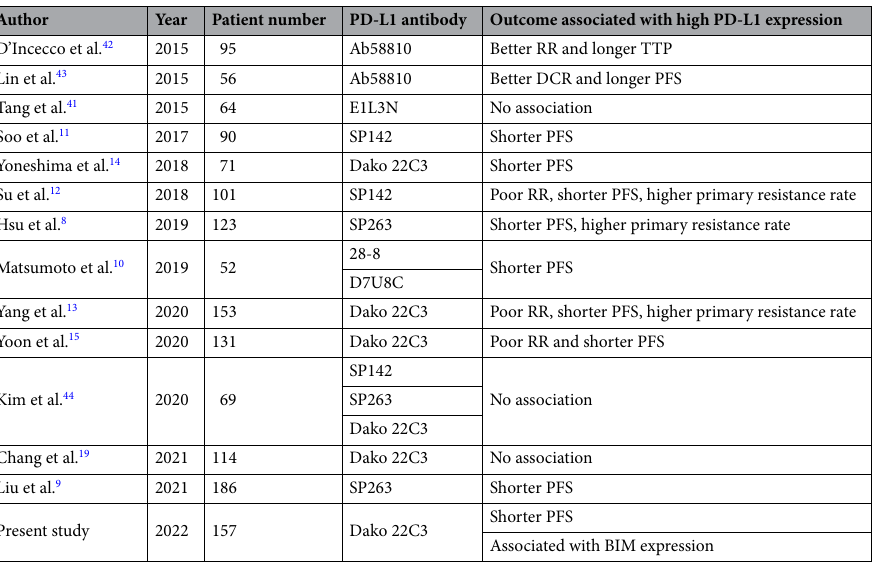
Table 3. Summary of data regarding the prognostic role of PD-L1 in treatment efficacy of EGFR-TKIs. DCR, disease control rate; EGFR, epidermal growth factor receptor; PFS, progression-free survival; RR, response rate; TKIs, tyrosine kinase inhibitors; TTP, time to